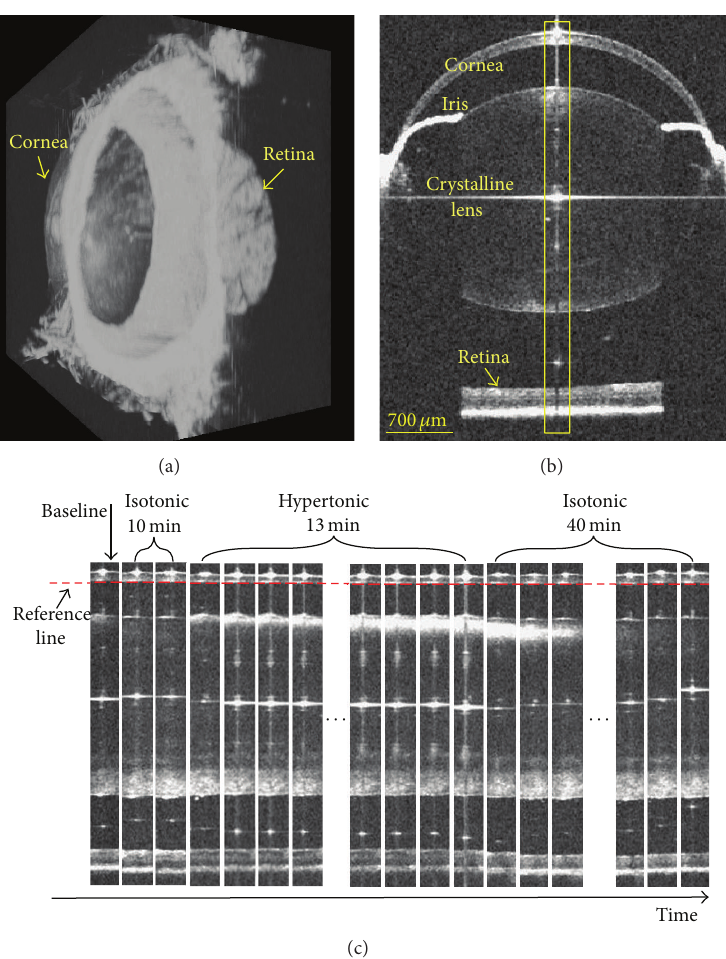
Figure1:OCTfull-eyeimaginganddynamicresponsetohypertonicchallengeandreversalinmousemodel.(a)Three-dimensionalrendering of the OCT full-eye imaging of mouse. (b) Representative OCT cross-section image in the horizontal meridian. As marked by the yellow rectangular region in (b), a serial of clips around the corneal vertex reflection line were extracted and displayed along the time dimension to demonstrate the dynamic response in (c). In the depth direction, all clips were aligned along the posterior